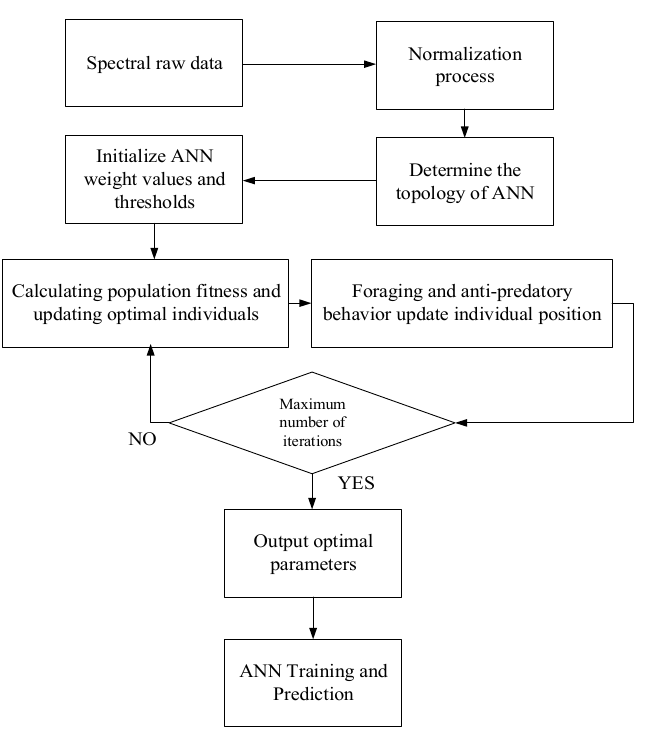
Figure 8. The sparrow search algorithm optimization ANN flow chart. The regression coefficients of the training set, validation set, and prediction set before and after the optimization of the ANN model with SSA are shown in Figure 9. Figure 9a shows the before optimization and Figure 9b shows the regression coefficients after optimization. The results show that the correlation coefficient (R) of the modeling set, prediction set, and validation set all reach above 0.96 after the optimization of ANN model parameters and thresholds by the SSA sparrow search algorithm, and the optimization effect is obvious.